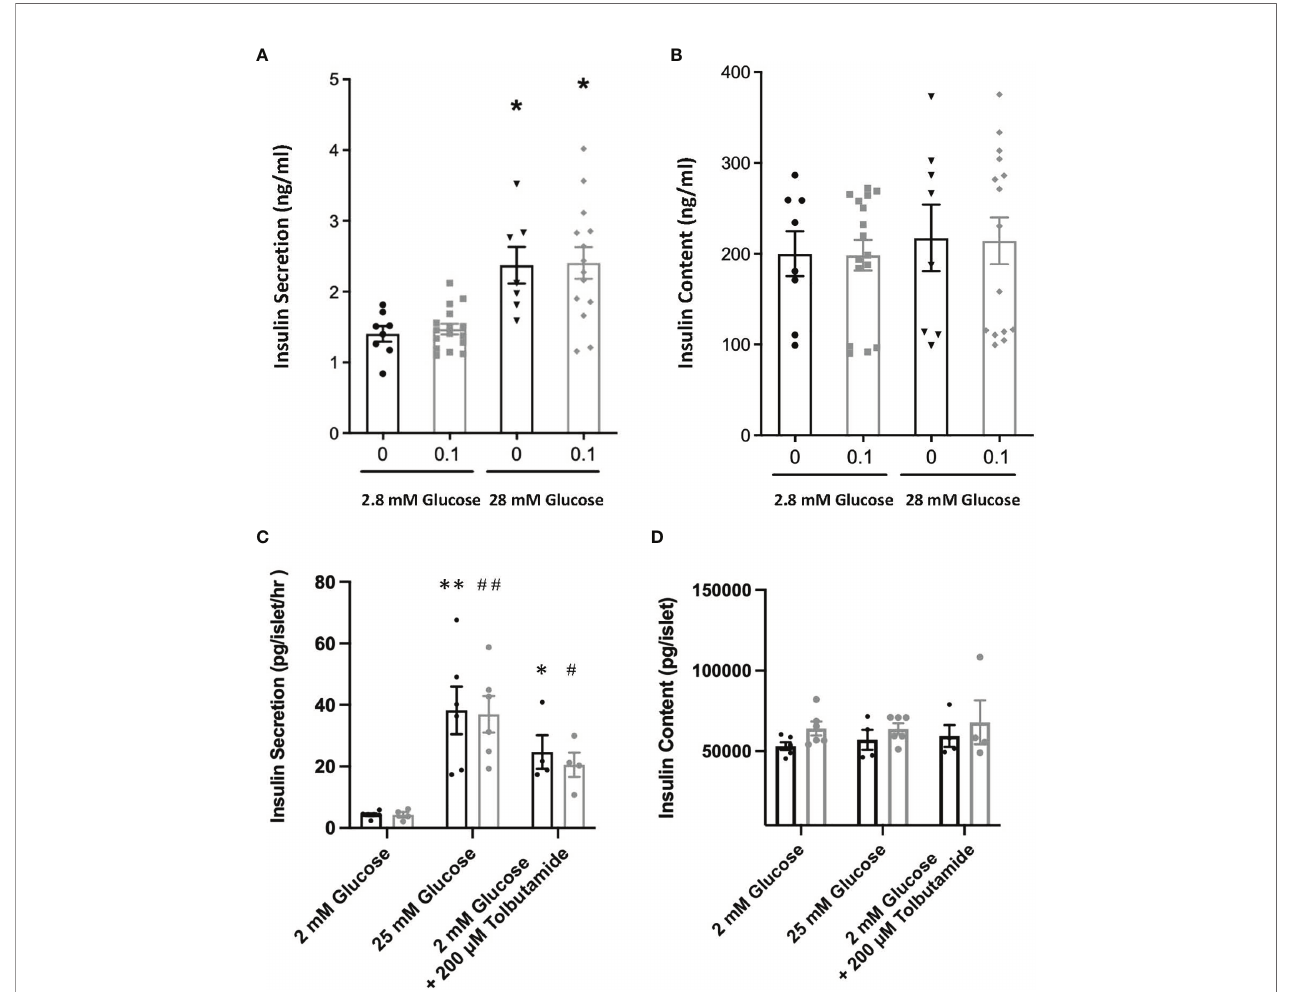
FIGURE 6 | Glucose stimulated insulin release (A) and cellular content of insulin (B) from INS1E cells pre-treated with or without 0.1 m g/ml PTN following incubation with either 2.8 mM or 28.8 mM glucose. *p < 0.05 vs. 2.8 mM glucose (n=8-12). Glucose stimulated insulin release (C) and cellular content (D) of insulin from isolated mouse islets of Langerhans pre-incubated with (grey) or without (black) 1 m g/ml PTN and following incubation with either 2 mM glucose, 2 mM glucose with tolbutamide, or 25 mM glucose. *p < 0.05, **p < 0.01 vs. 2 mM glucose without PTN, and (n=6). and # p < 0.05, ## p < 0.01 vs. 2 mM glucose with PTN